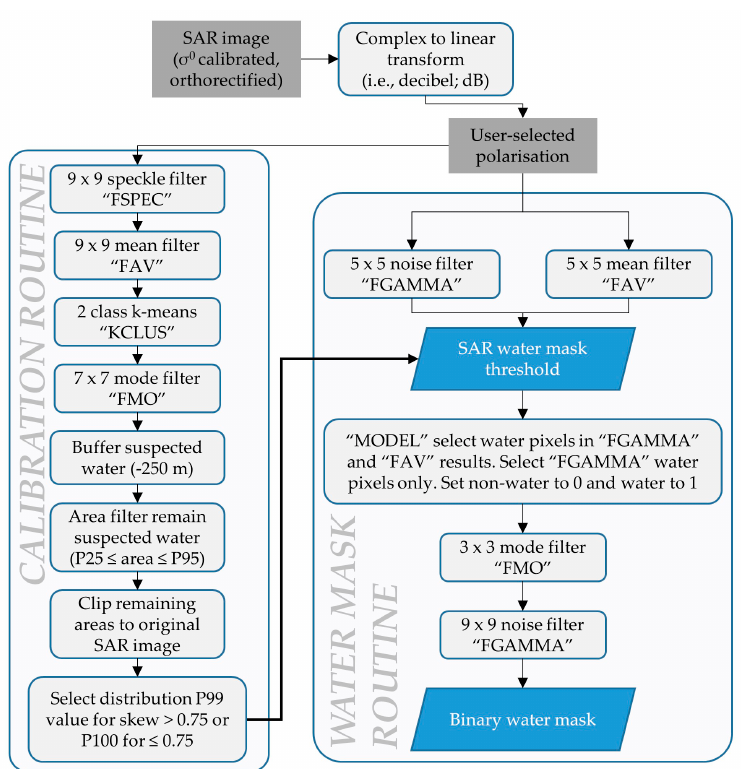
Figure 2. Schematic workflow for determining an objective Synthetic Aperture Radar (SAR) water mask threshold (calibration routine) for use in the derivation of a binary water mask from SAR imagery (water mask routine), adapted from White et al. [18]. SAR data are processed through a series of ArcMap and PCI Geomatica functions, noted in quotation marks.